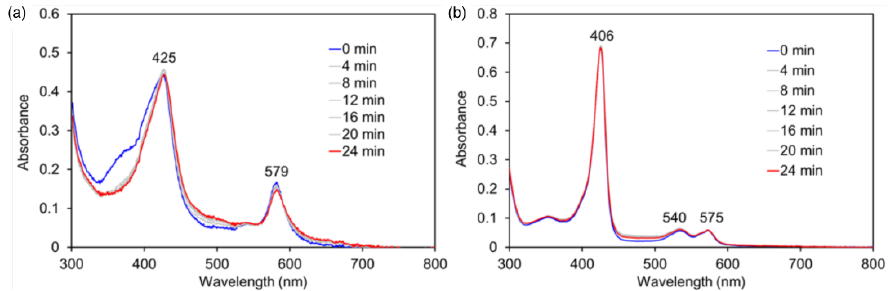
Figure 12. UV-vis spectral changes upon addition of H 2 O 2 to a solution of CoCor containing 5% v/v pyridine ( a ) and rMb(CoPor) ( b ) in the presence of guaiacol. [CoCor] = [rMb(CoPor)] = 8 μM, [H 2 O 2 ] = 10 mM, [guaiacol] = 10 mM in 100 mM potassium phosphate buffer (pH 7.0), 25 °C.